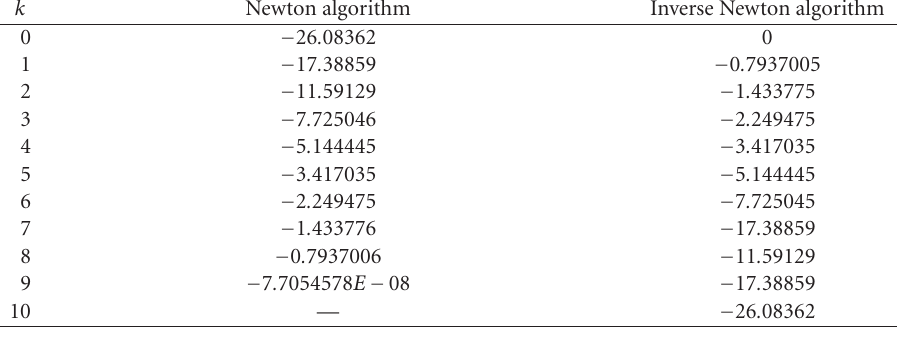
Table 5.2. Algorithm of Newton and its inverse.